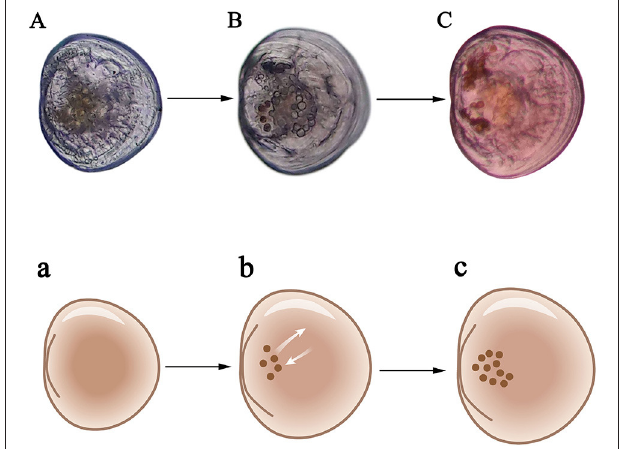
FIGURE 2 | Criteria for successful implantation of zooxanthellae for larvae. (A) Late umbo-larvae; (B) Pediveliger which begins feeding on zooxanthellae; (C) Mature pediveliger with over 10 zooxanthellae. a–c are schematic diagrams corresponding to (A–C) .